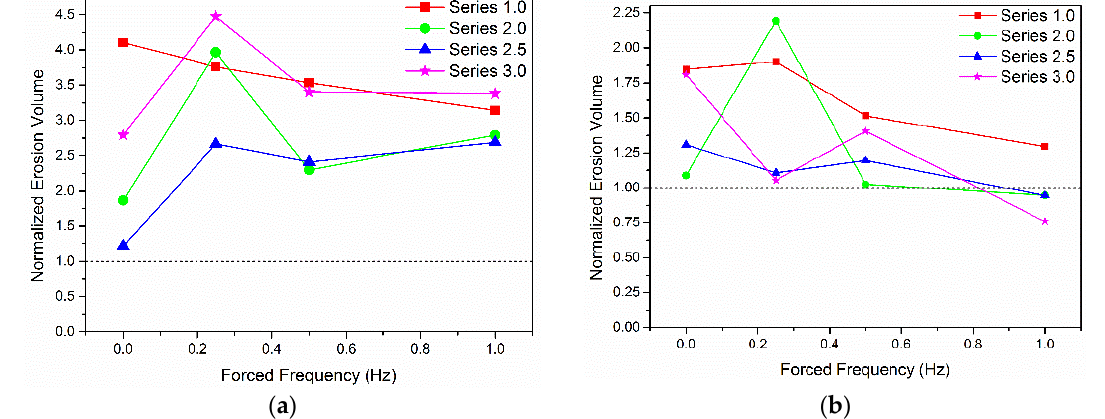
Figure 22. The erosion performance under forced excitation: ( a ) normalized volume; ( b ) normalized